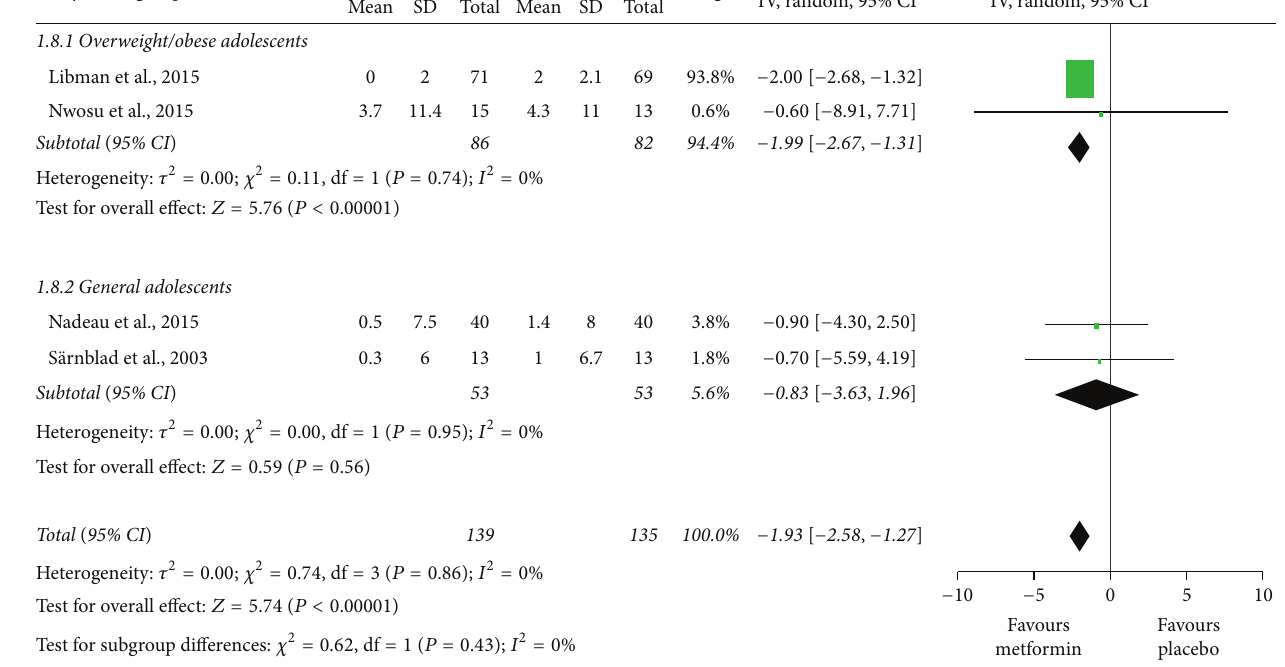
Study or subgroup